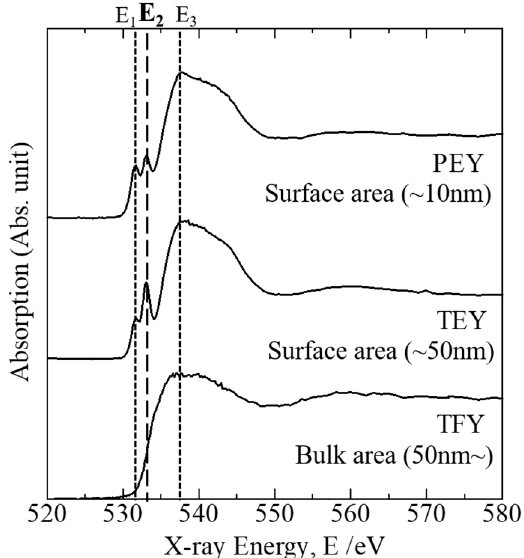
Figure 4. Oxygen K-edge XANES spectra of porous glass obtained using different collection modes. The PEY and TEY modes reflect the ionic structure in surface area, whereas the TFY mode reflects that in the bulk.